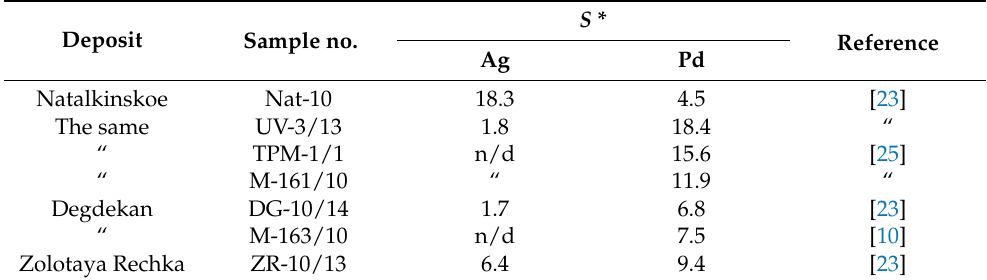
Table 7. NAP selectivity to Ag and Pd for pyrites of several orogenic gold deposits (Magadan region, Northeastern Russia). Deposit Sample